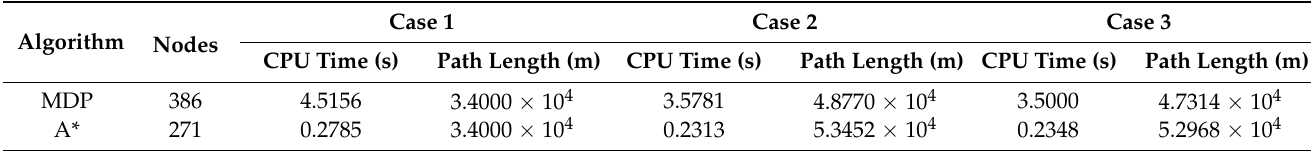
Table 4. The performance comparison between MDP and A* algorithms.